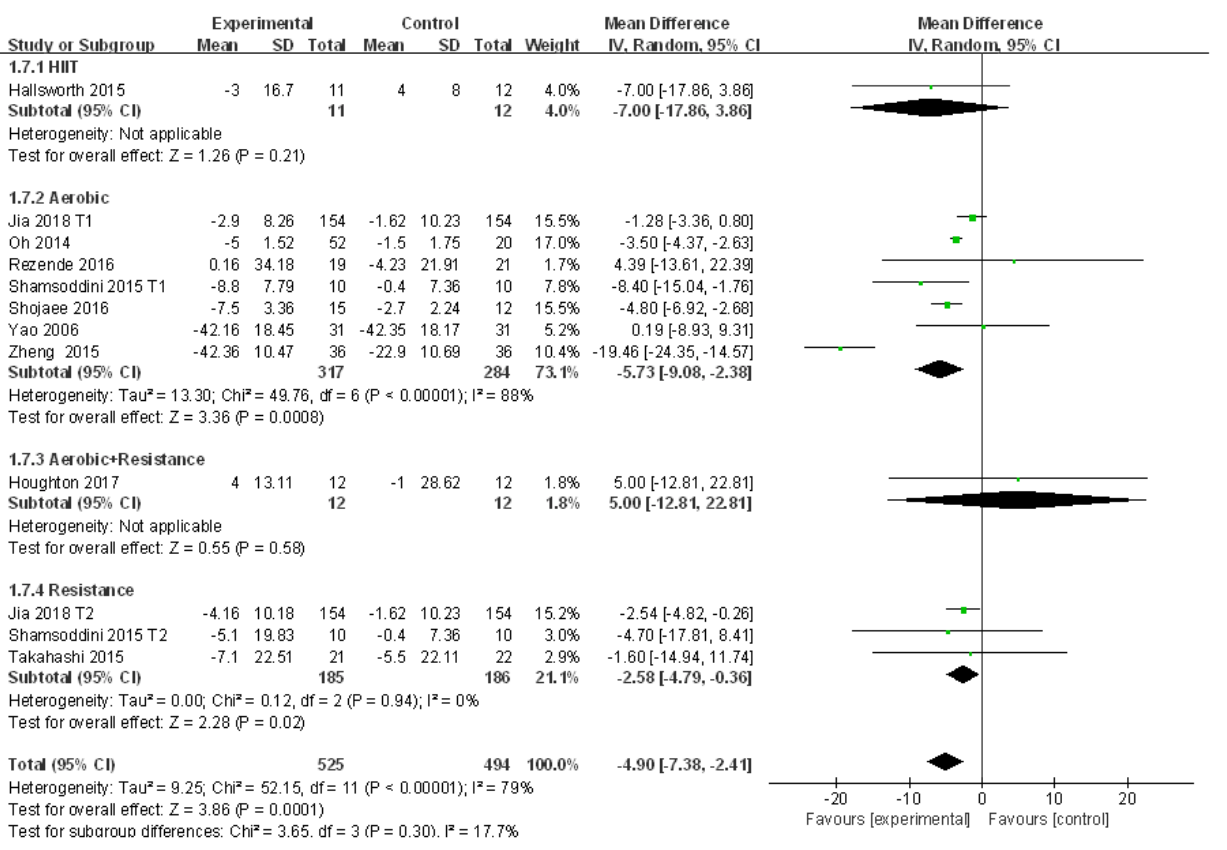
Figure 8. Subgroup analysis of different exercise styles on aspartate aminotransferase (AST).